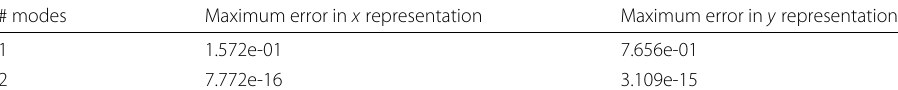
Fig. 28 Two-modes ( i = 1 , 2) SAR of the NURBS-based mapping: a M T ( η ) Y 2 i d M T 2